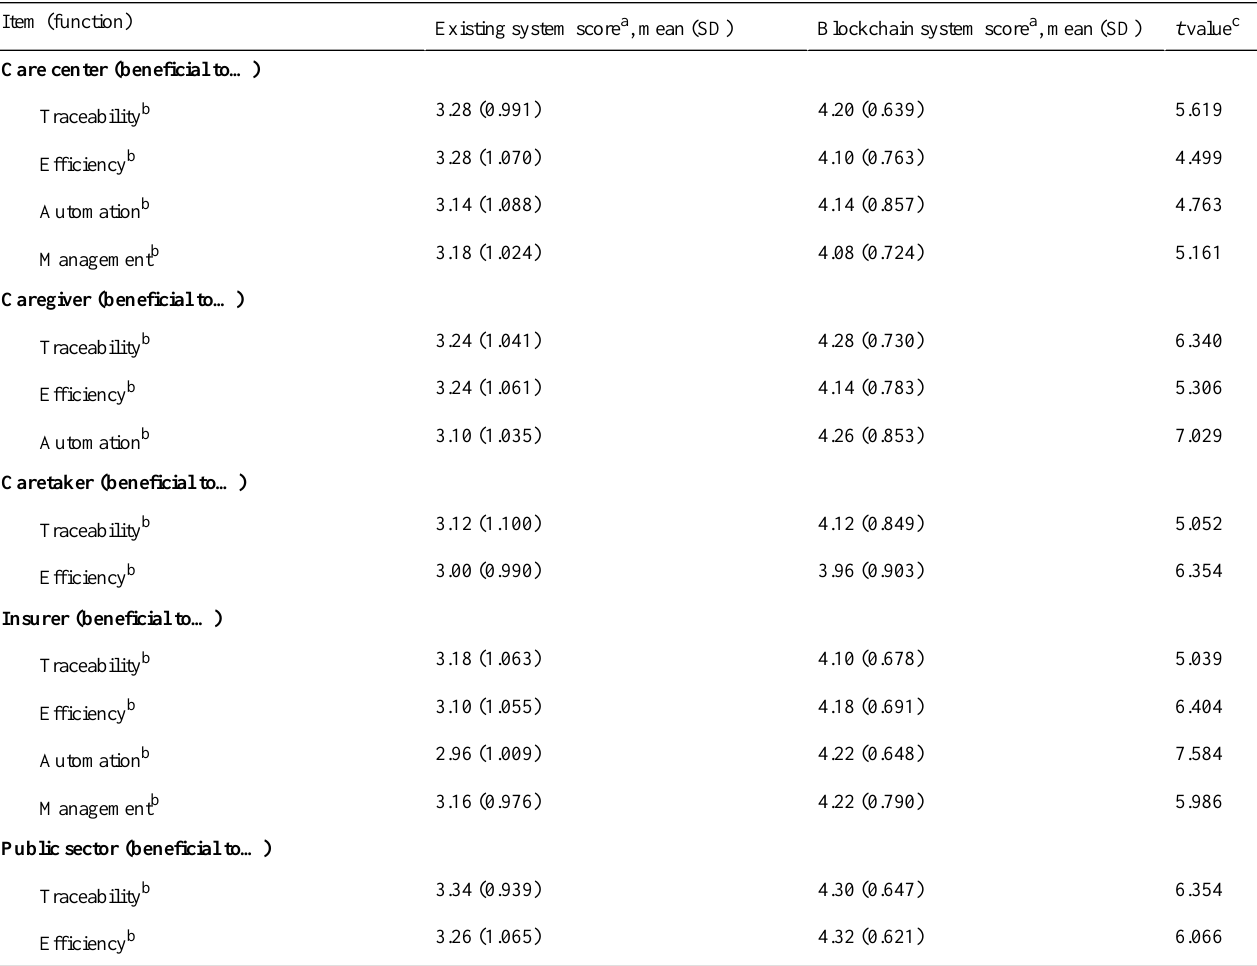
Table 2. Comparison of construct scores between the existing system and the proposed blockchain-based